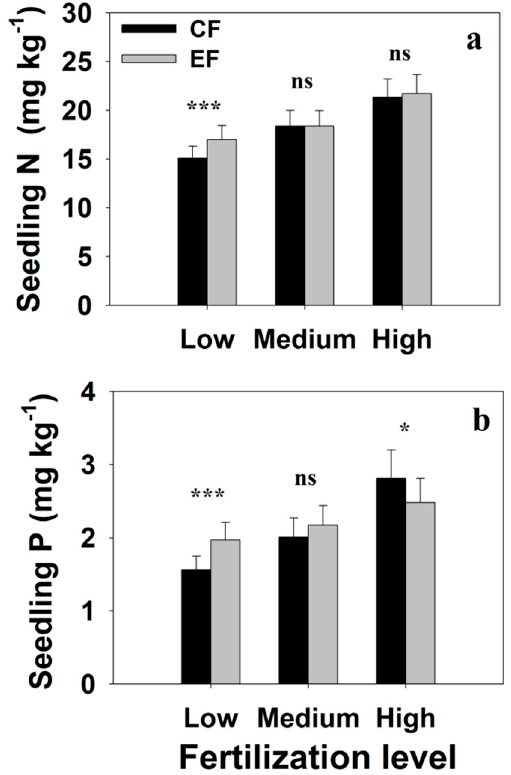
Figure 3. The effects of two fertilization regimes on ( a ) nitrogen (N) and ( b ) P nutrient concentrations of seedlings across three fertilization levels. CF, conventional constant rate fertilization; EF, exponential fertilization. * and *** indicate significant difference at p < 0.05 and p < 0.001, respectively; ns indicates no significant difference.